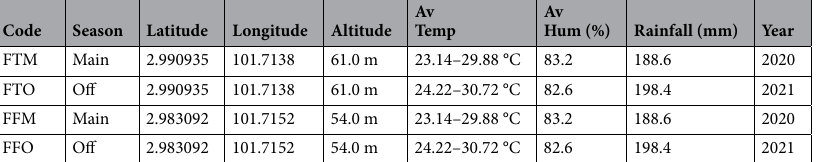
Table 2. Environmental description of the experimental site. FTM Field 10 main season, FTO Field 10 off season, FFM Field 15 main season, FFO Field 15 off season, Main season May–September, Off season November–March, Av. Temp. Average temperature, Av. Hum. Average humidity. Sources: https:// en. clima te- data. org/ asia/ malay sia/ selan gor/ mardi- serda ng- 97161 3/# clima te- table.